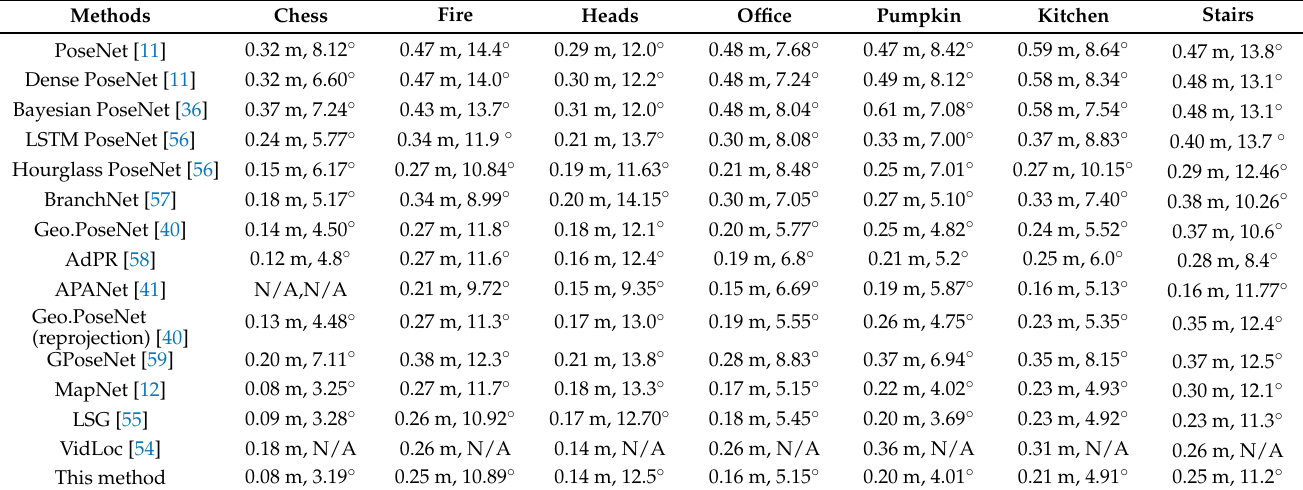
Table 4. Localization errors of the fusion of local and global features and other methods in the 7Scenes dataset.